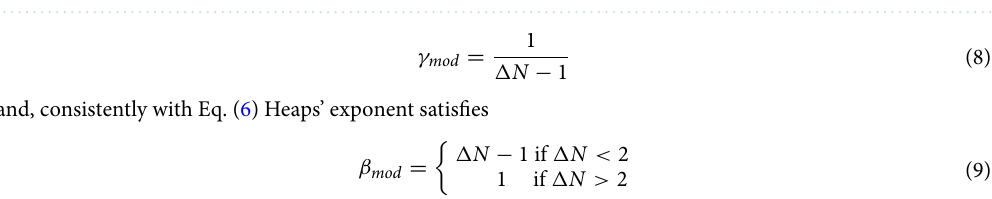
Figure 4. Schematic representation of the model. At each time step a unit of money is invested in a cryptocurrency selected with a probability proportional to its market cap, which is then increased by a unit. If such a cryptocurrency previously received other investments we move to the next time step (case a), while if it is the first time the cryptocurrency is selected we also introduce in the system (cid:31) N novel coins with unitary capitalization (case b). This last process mimics the adjacent possible mechanism behind the creation of new cryptocurrencies. Figure created with www. diagr ams.